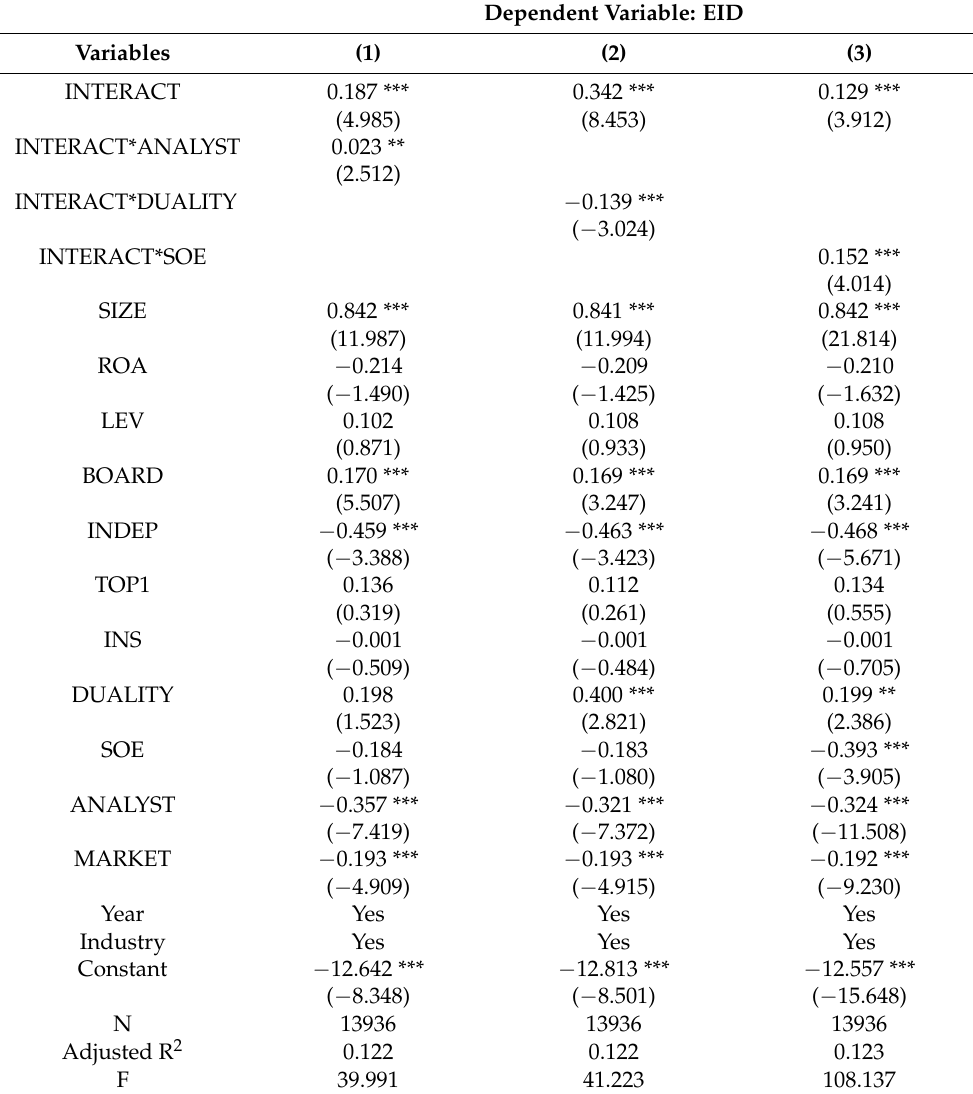
Table 8. Results of mechanism